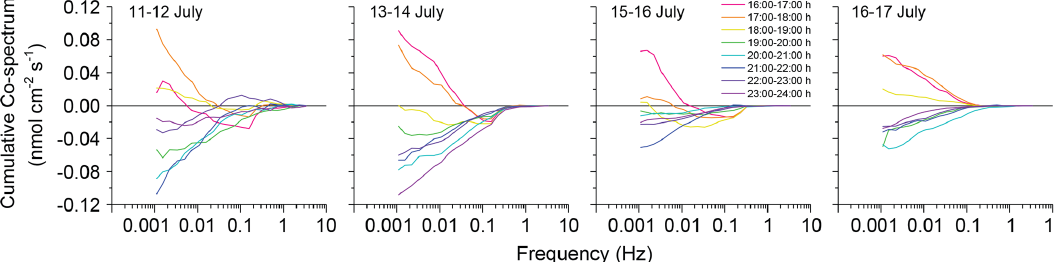
Figure 6. Change in the cumulative co-spectra for the 3S O 2 flux during the deployment week. Cumulative co-spectra were calculated for hourly intervals from 16:00 to 24:00 for the four deployment periods (0.12nmolcm − 2 s − 1 corresponds to 4.3mmolm − 2 h − 1 ). Colours indicate the time periods for which the co-spectra were calculated, with red, orange, and yellow (warm colours) depicting light periods before sunset (green). Blue and purple colours depict dark periods after